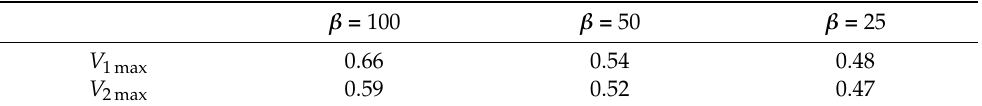
Figure 13. The maximum variation of x 1 versus ε for p = 19, q = 17 and β = 1